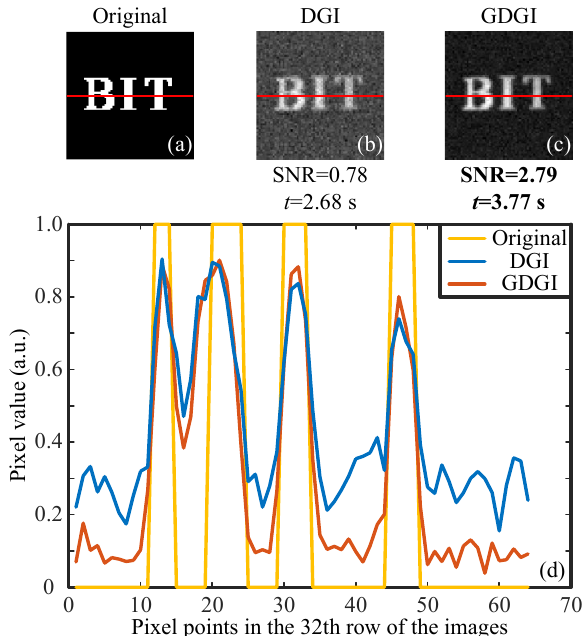
Figure 8. Experimental results of a binary object. ( a ) is the original image encoded onto DMD 2 , ( b , c ) are the experimental results recovered by the DGI and GDGI, and ( d ) gives cross-section plots of the grayscale images in the 32th